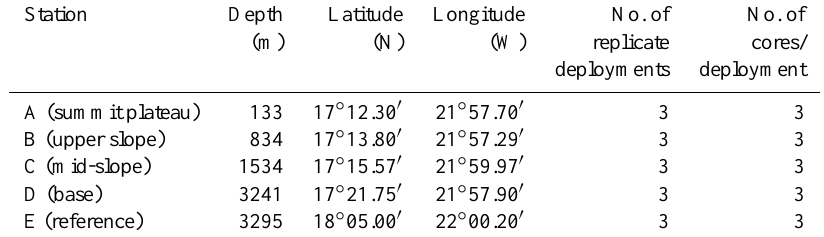
replicate cores/